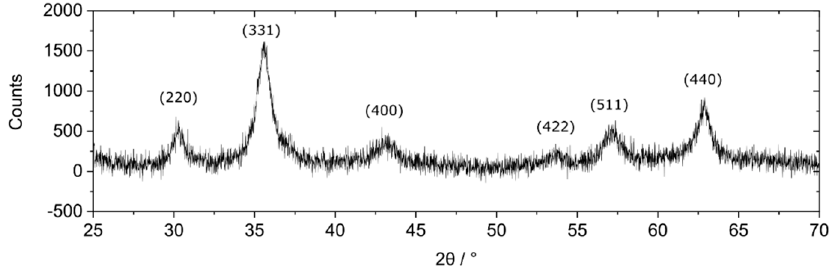
Figure 3. Diffractogram of magnetic nanoparticles. The background was subtracted from the presented data Cu K( α ).